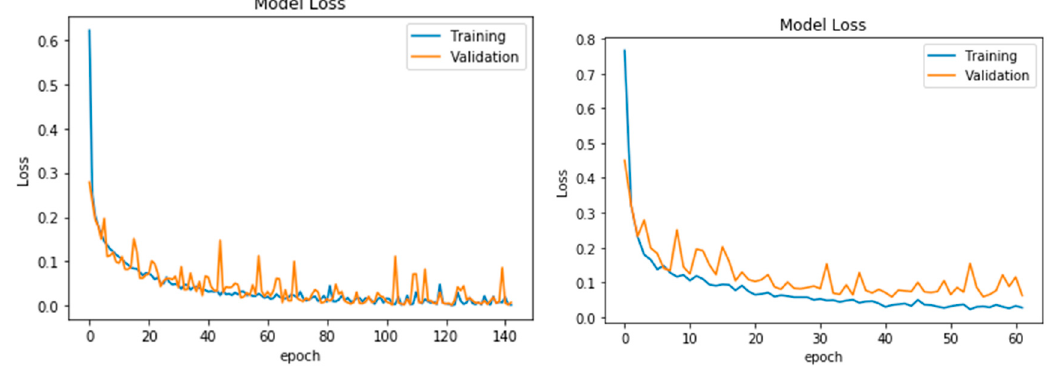
Figure 9. Training and validation loss of information without dropout when fusing DSM and RGB ( left ), and loss of information with RGB only ( right ) without dropout.